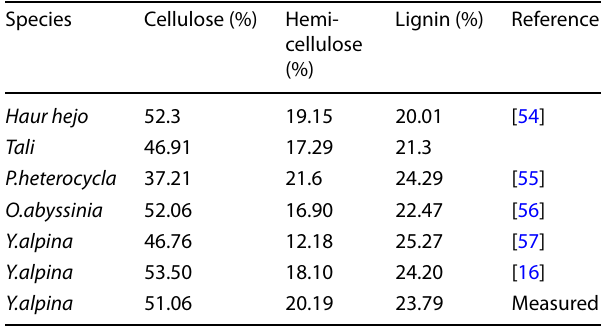
Table 5 Main chemical composition analysis of Y.alpina compared with other different bamboo species Species Cellulose (%) Hemi-